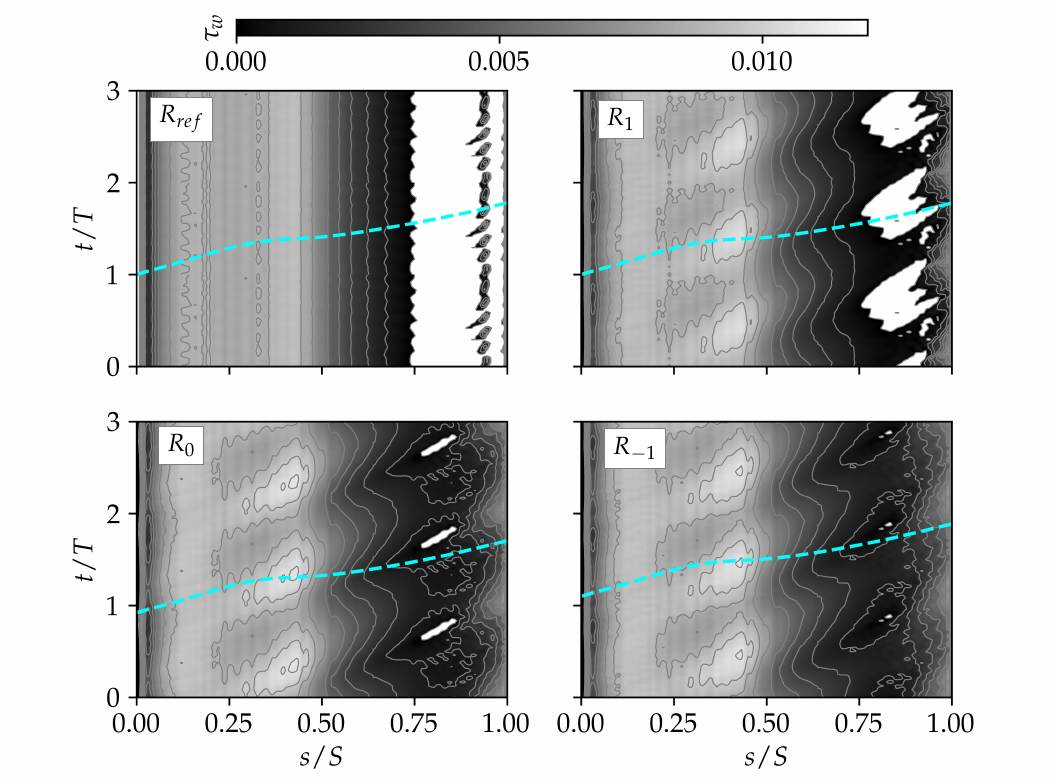
Figure 6. Space-time diagram of the suction side wall shear stress τ w along the streamwise direction for three bar passing periods, for cases R ref (no bars), R 1 (counter-clockwise), R 0 (non-rotating) and R − 1